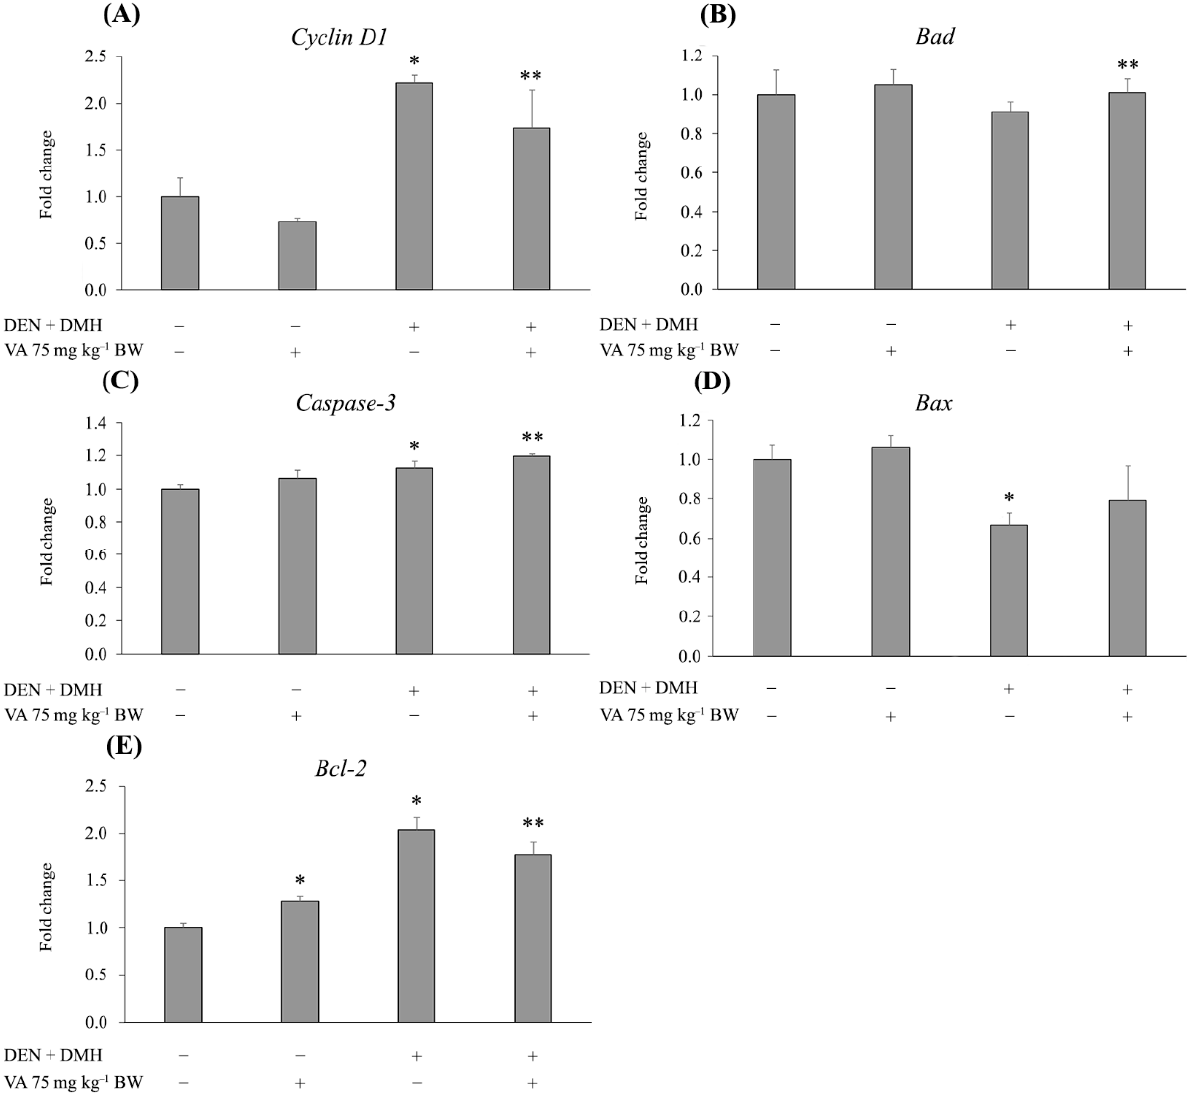
Figure 4. The effect of VA on the expression of genes related to cell proliferation and apoptosis. ( A ) Cyclin D1. ( B ) Bad. ( C ) Caspase-3. ( D ) Bax. ( E ) Bcl-2. Values are expressed as mean ± SD. * Significantly different from negative control group, p < 0.05. ** Significantly different from positive control group, p < 0.05. DEN: diethylnitrosamine, DMH: 1,2-dimethylhydrazine, NSS: normal saline solution, VA: vanillic acid.